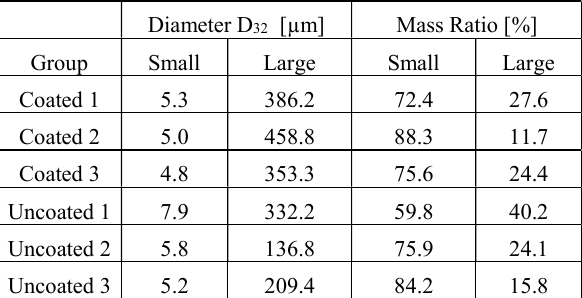
Table 1. Droplet size distribution results.